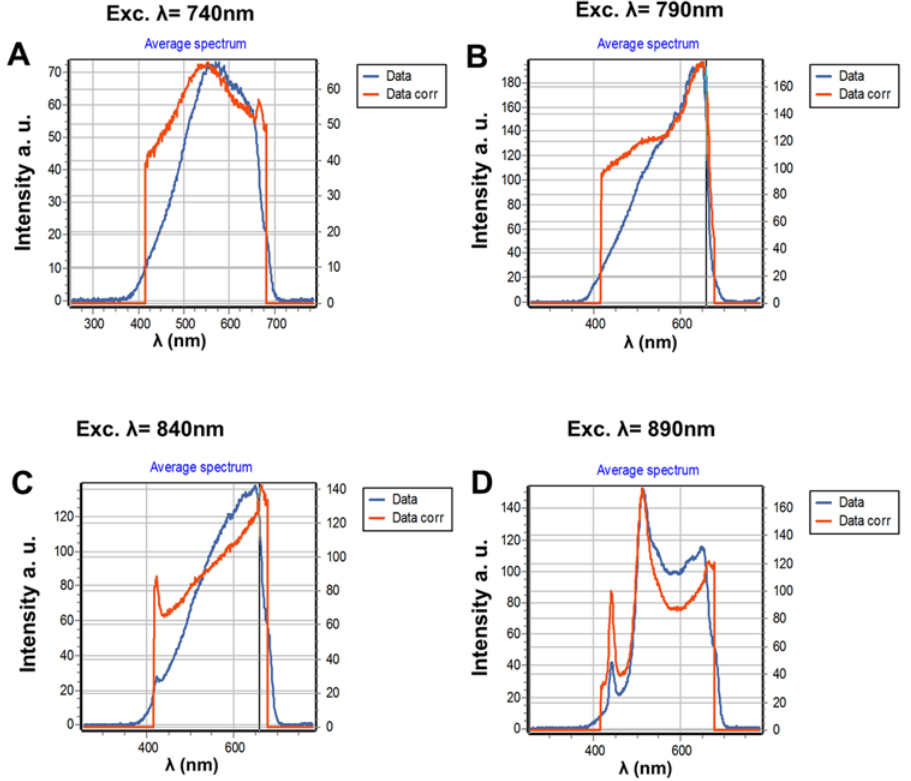
Fig 4. Spectrum of a AuNP excited at 4 different wavelengths and with an orientation of 45 degrees for the linear polarizer. This sample was added with a solution of 100nM EGFP . (A) EGFP is minimally excited at 740 nm and we see the typical spectrum of the metallic nanoparticle. (B) at 790nm we broad emission of the nanoparticle shifts toward the red and a band starts to appear in the 520nm region typical of EGFP. (C) at 840nm the SHG signal starts to be observed. (D) at 890 nm the fluorescence from the EGFP is strongly enhanced and this fluorescence is clearly distinguishable in the 529 nm region. At this excitation wavelength there is also a very strong SHG